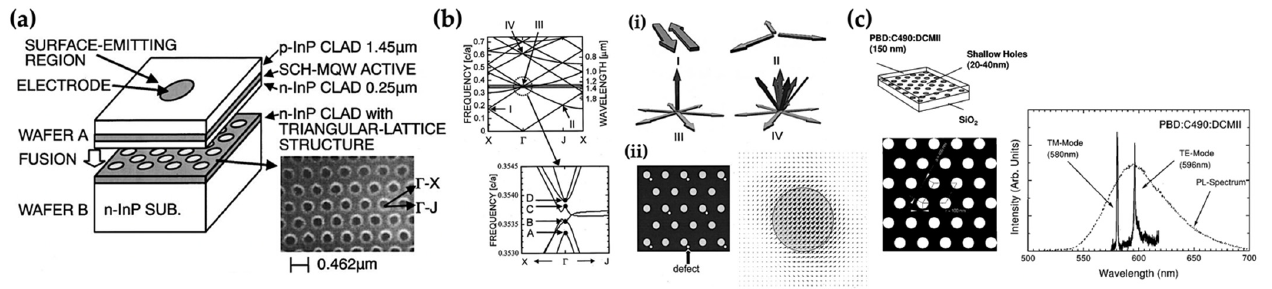
Figure 5. ( a ) Schematic illustration of the surface-emitting laser embedded with a 2D triangular- lattice structure via wafer fusion technique [33]. ( b ) Band diagram of a 2D photonic crystal [35]. Insets: ( i ) Schematic illustration for the propagating directions of coupled waves at points I–IV. ( ii ) Schematic illustration of defects introduced into a 2D photonic crystal. The corresponding electric field pattern can be calculated via finite-difference time-domain (FDTD) method. ( c ) Schematic illustration of layer structure with a two-dimensional triangular lattice and the corresponding emission spectra from the device [34]. Two lasing peaks with different polarizations can be observed. In addition, the spontaneous emission spectrum from the gain medium is shown with a dashed line.